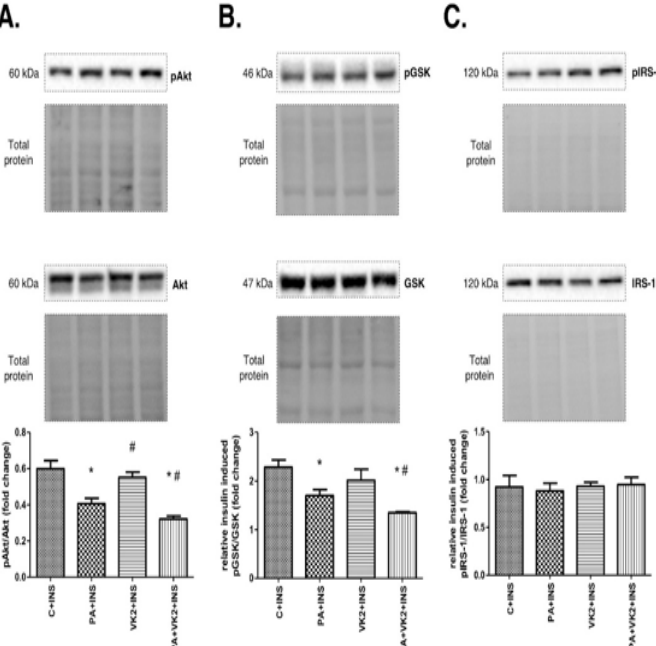
Figure 4. The total expression ratio of phosphorylated and unphosphorylated proteins from insulin signaling pathway—namely, phosphorylated protein kinase B/protein kinase B (pAkt/Akt) ( A ), phosphorylated glycogen synthase kinase/glycogen synthase kinase (pGSK/GSK) ( B ) and phosphorylated insulin receptor substrate 1/insulin receptor substrate 1 (pIRS-1/IRS-1) ( C ). The cells were incubated for 16 h with palmitic acid and/or vitamin K2 with the addition of insulin for last 12 min of incubation. Proteins from insulin signaling pathway were assessed by Western blotting as described in the Materials and Methods section. The results are presented as mean ± SD and are based on six independent determinations. *– P < 0.05 significant difference vs control group with addition of insulin, #– P < 0.05 significant difference vs palmitate group with addition of insulin; C + INS–control and insulin, PA + INS–palmitate and insulin, VK2 + INS–vitamin K2 and insulin, PA + VK2 + INS–palmitate, vitamin K2 and insulin.